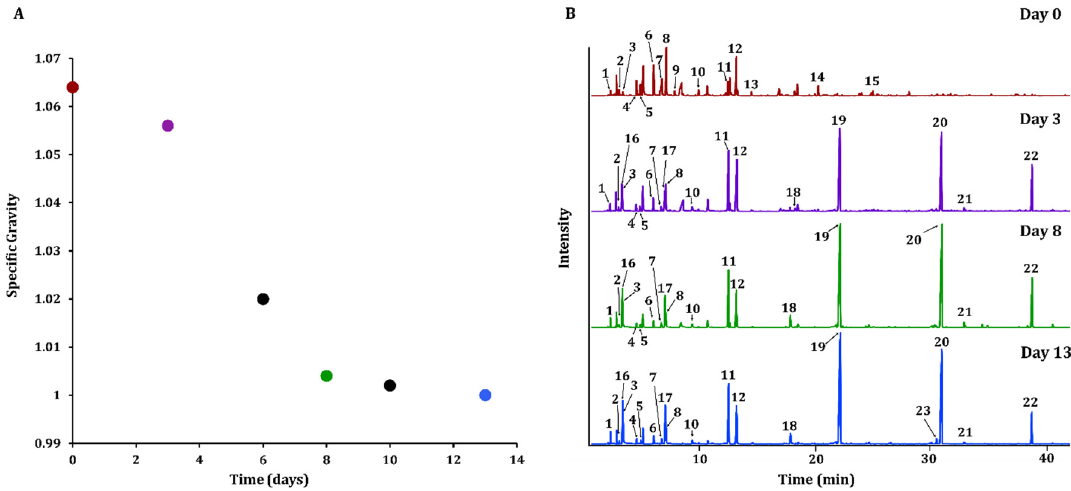
Figure 4. A hydrometer was used to measure specific gravity throughout a cider fermentation to monitor fermentation progression ( A ). Specific gravity measurements were taken before yeast inoculation ( red ), at various stages during fermentation ( purple, black, green ), and when fermentation was complete ( blue ). Four chromatograms were obtained by headspace solid phase microextraction gas chromatography–mass spectrometry (HS-SPME GC-MS), with a DVB / CAR / PDMS fiber, in order to compare changes in aroma profiles based on volatile constituents ( B ). All chromatographic peaks are numbered in order of their observation throughout the fermentation process. Peaks one